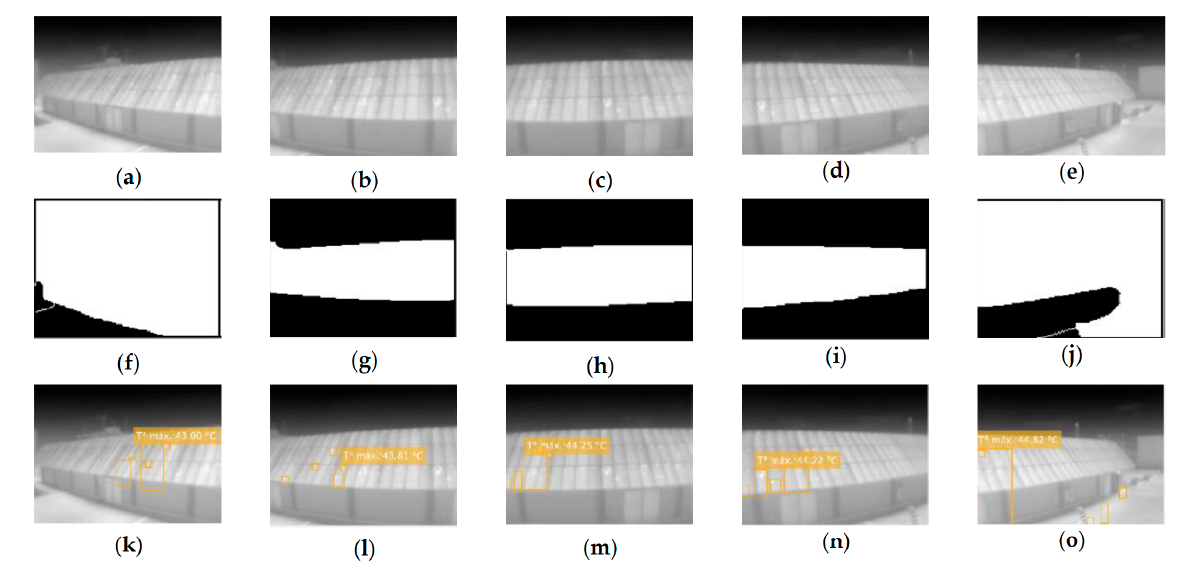
Figure 17. Variation of the horizontal angle ( − 35°, − 15°, 0°, 15°, 35°) for the distance of 7 m. ( a – e ) Raw images; ( f – j ) segmented images; ( k – o ) final images.